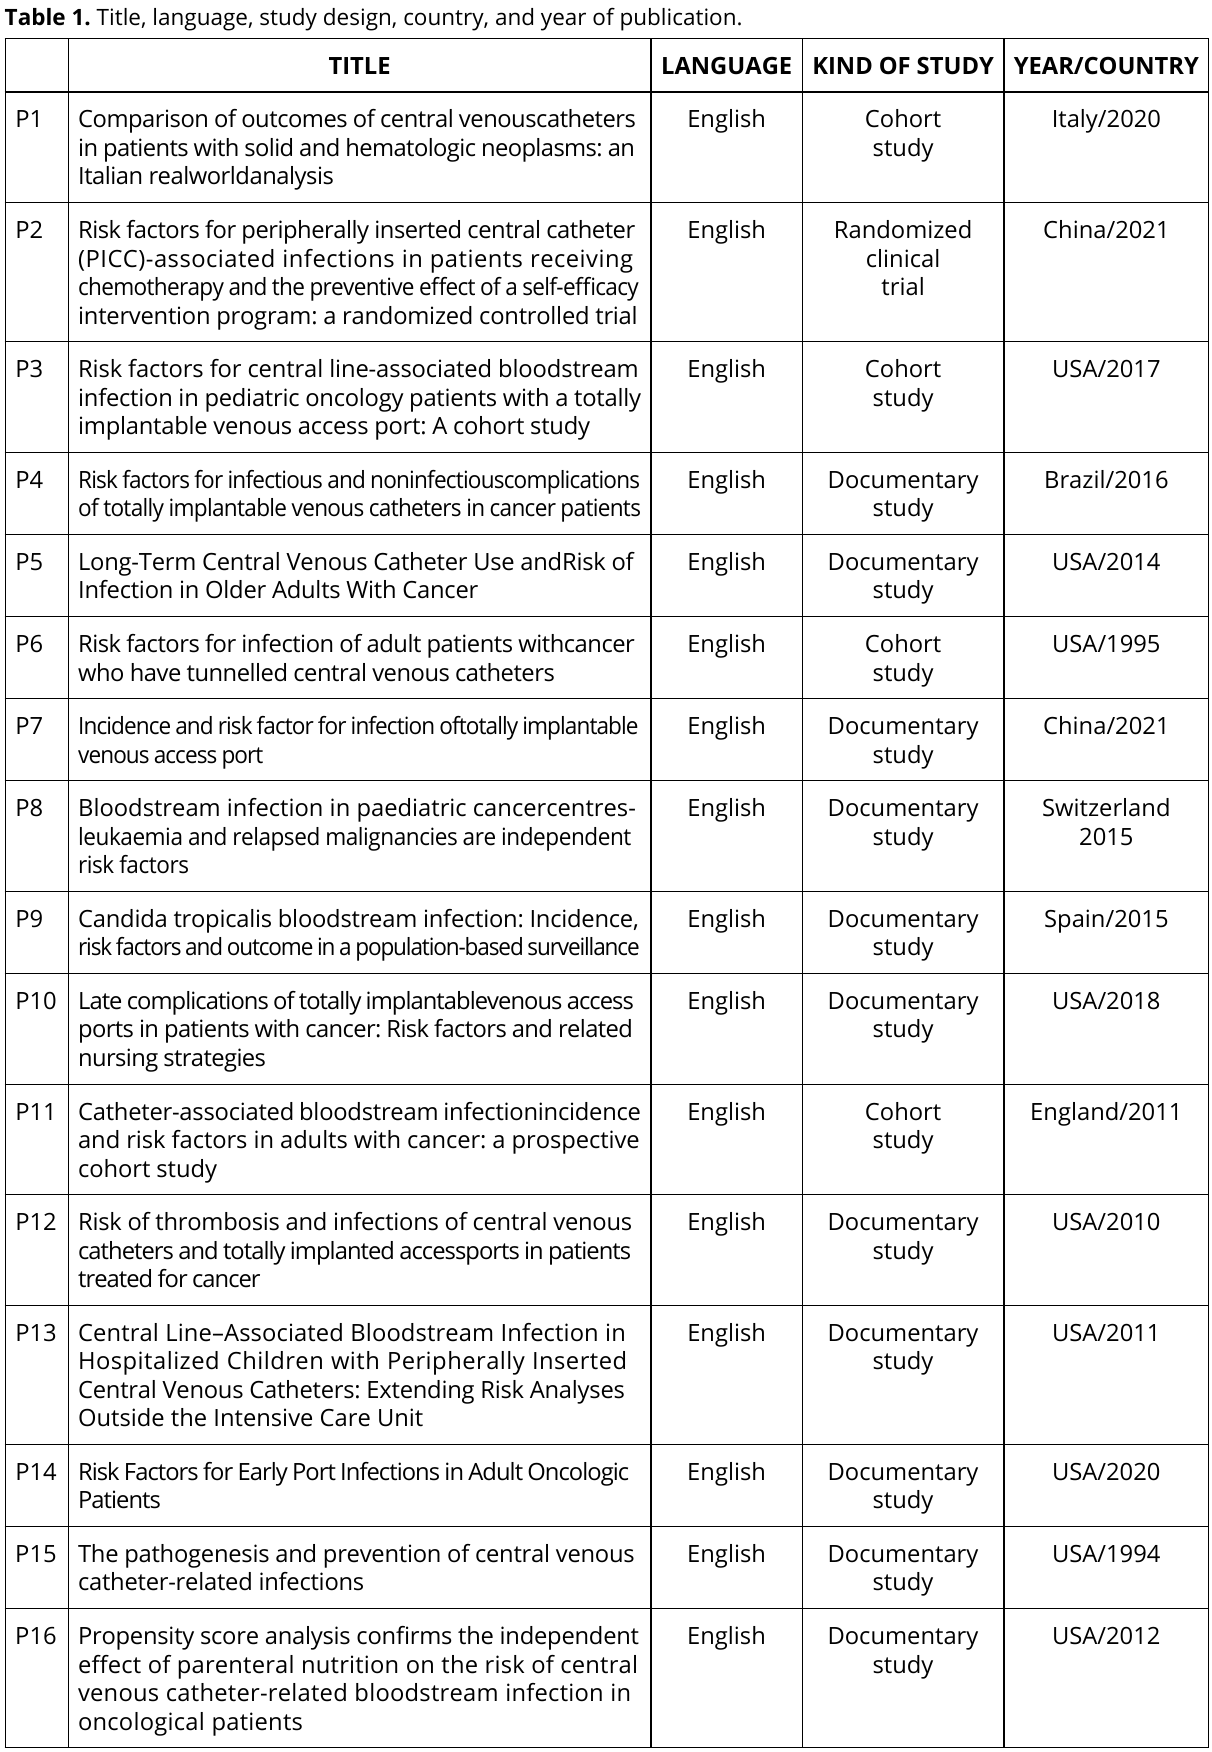
Table 1. Title, language, study design, country, and year of